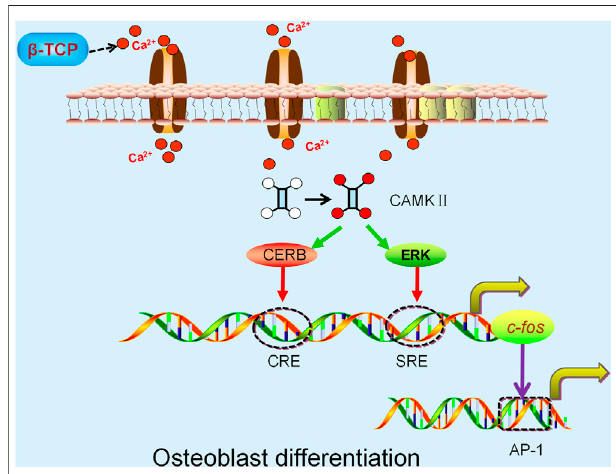
FIGURE 2 | β -TCP-released Ca 2+ activates the α -CaMKII pathway and modulatesCREBandextracellularERKactivity.TheactivationofCRE-binding protein (CREB) and extracellular signal-regulated kinase (ERK) increase the transactivation of SRE and CRE respectively, both of which regulate the c-fos promoter resulting in enhanced expression of AP-1 and ultimately osteoblast